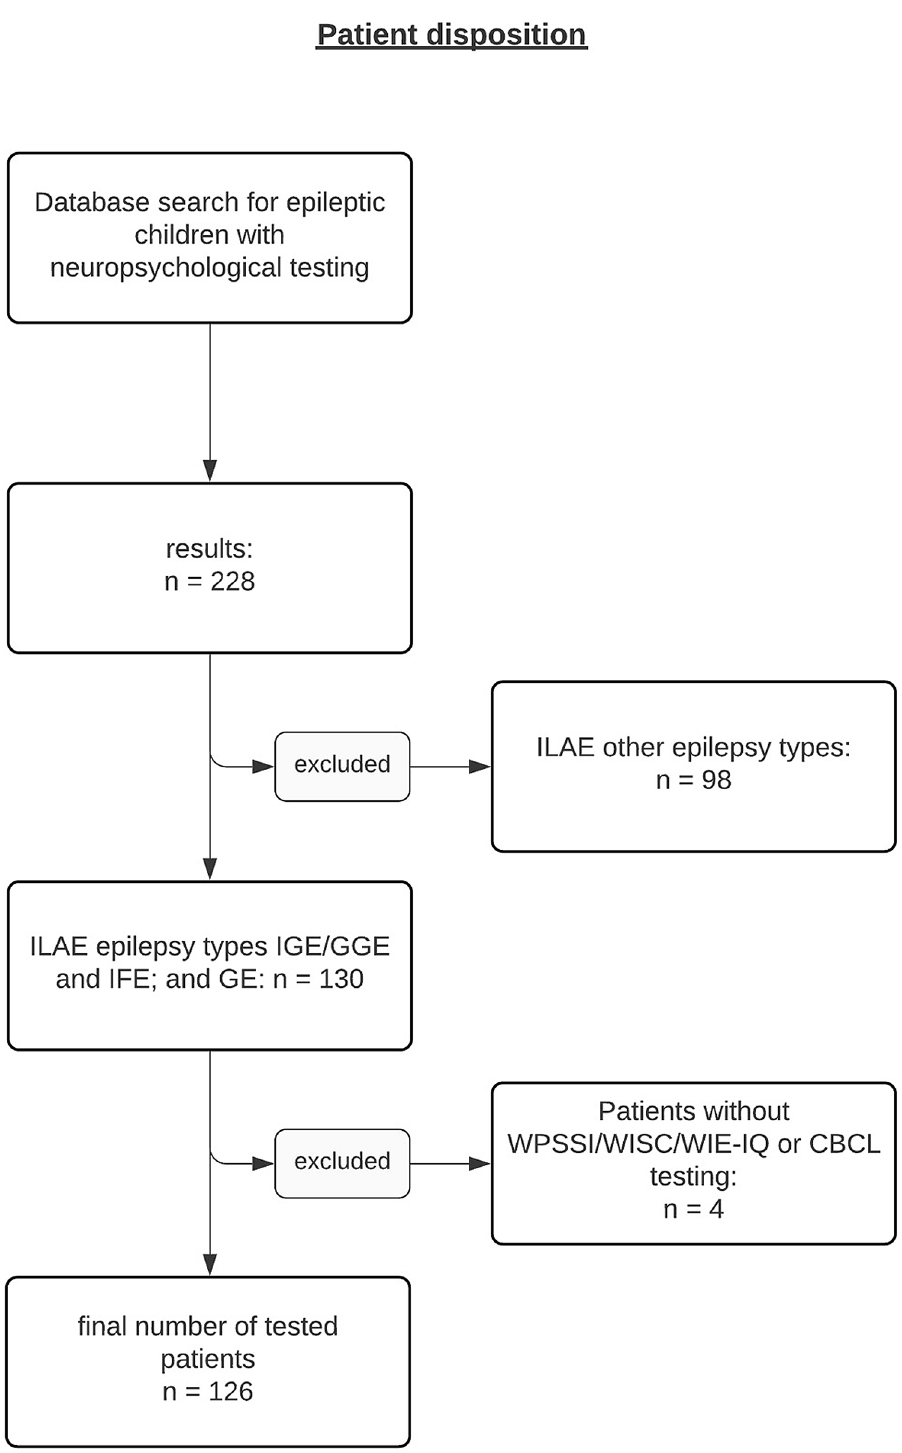
Figure 1. Patient disposition showing step-by-step selection process with inclusion and exclusion